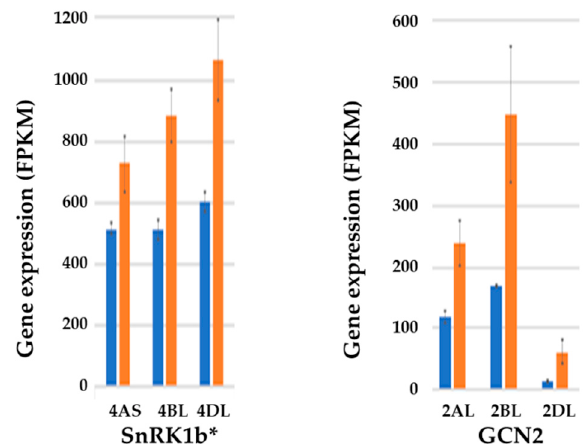
Figure 6. Graphs (means and standard errors) of expression levels (FPKM) of genes encoding SNF1-related protein kinase-1 (SnRK1) type b* (left) and general control nonderepressible-2 (GCN2) in the embryo of wheat ( Triticum aestivum ) genotype SR3 at 21 days post-anthesis. Sulphur was either supplied (blue columns) or withheld (brown columns). Results for each homeologue are shown separately, with chromosomal locations indicated. The increase in expression of the 4BL and 4DL homeologues of the SnRK1b * gene in response to sulphur deficiency was significant ( p = 0.0426 and p = 0.0377, respectively), as was the increase in expression of all three GCN2 homeologues ( p = 0.03114, < 0.01, and 0.01313 for the 2AL, 2BL, and 2DL homeologues, respectively). Replotted from RNA-seq data provided in